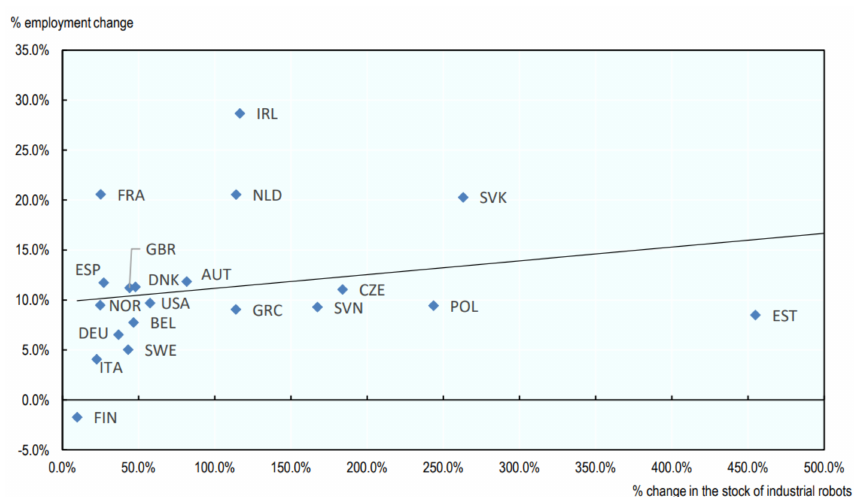
Figure 3. Correlation between average percentage change in employment by country and percentage change in the use of industrial robots during the period 2012–2019. Source: Georgieff, A. and A. Milanez (2021), “What happened to jobs at high risk of automation?” OECD Social, Employment and Migration Working Papers, No. 255, OECD Publishing, https://doi.org/10.1787/10bc97f4-en, accessed on 21 February